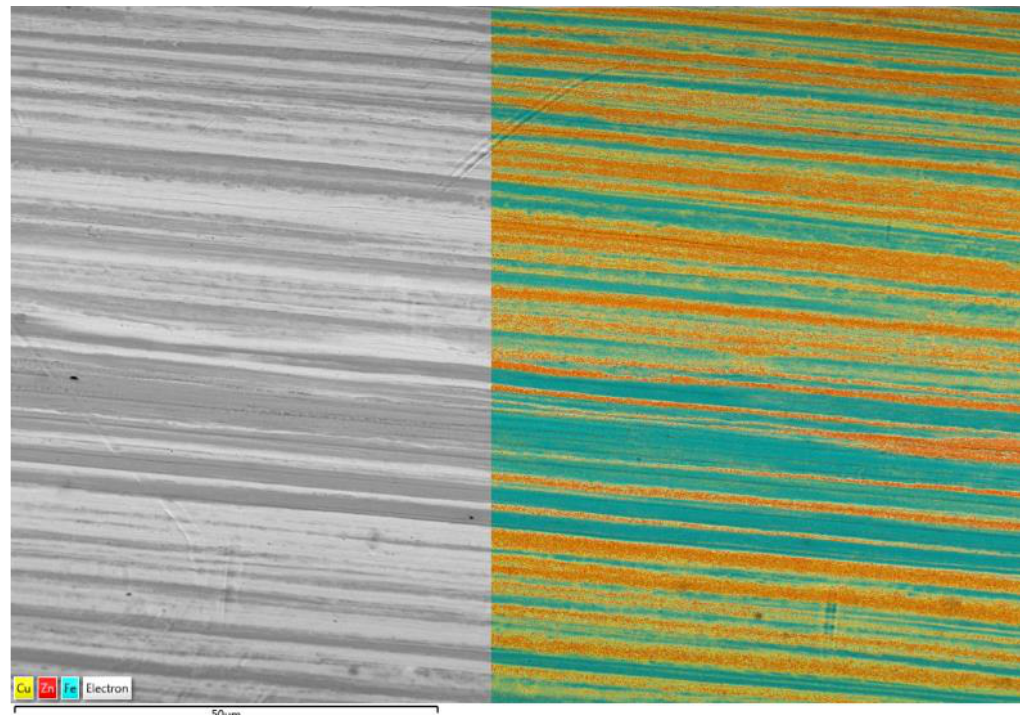
Figure 4. SEM image and EDS mapping of the brass coated steel fiber surface.